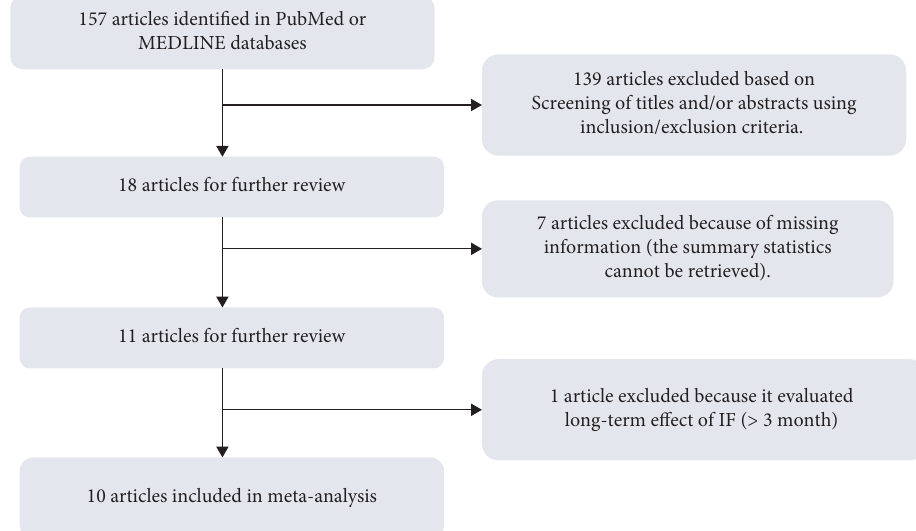
Figure 1: PRISMA diagram for the systematic